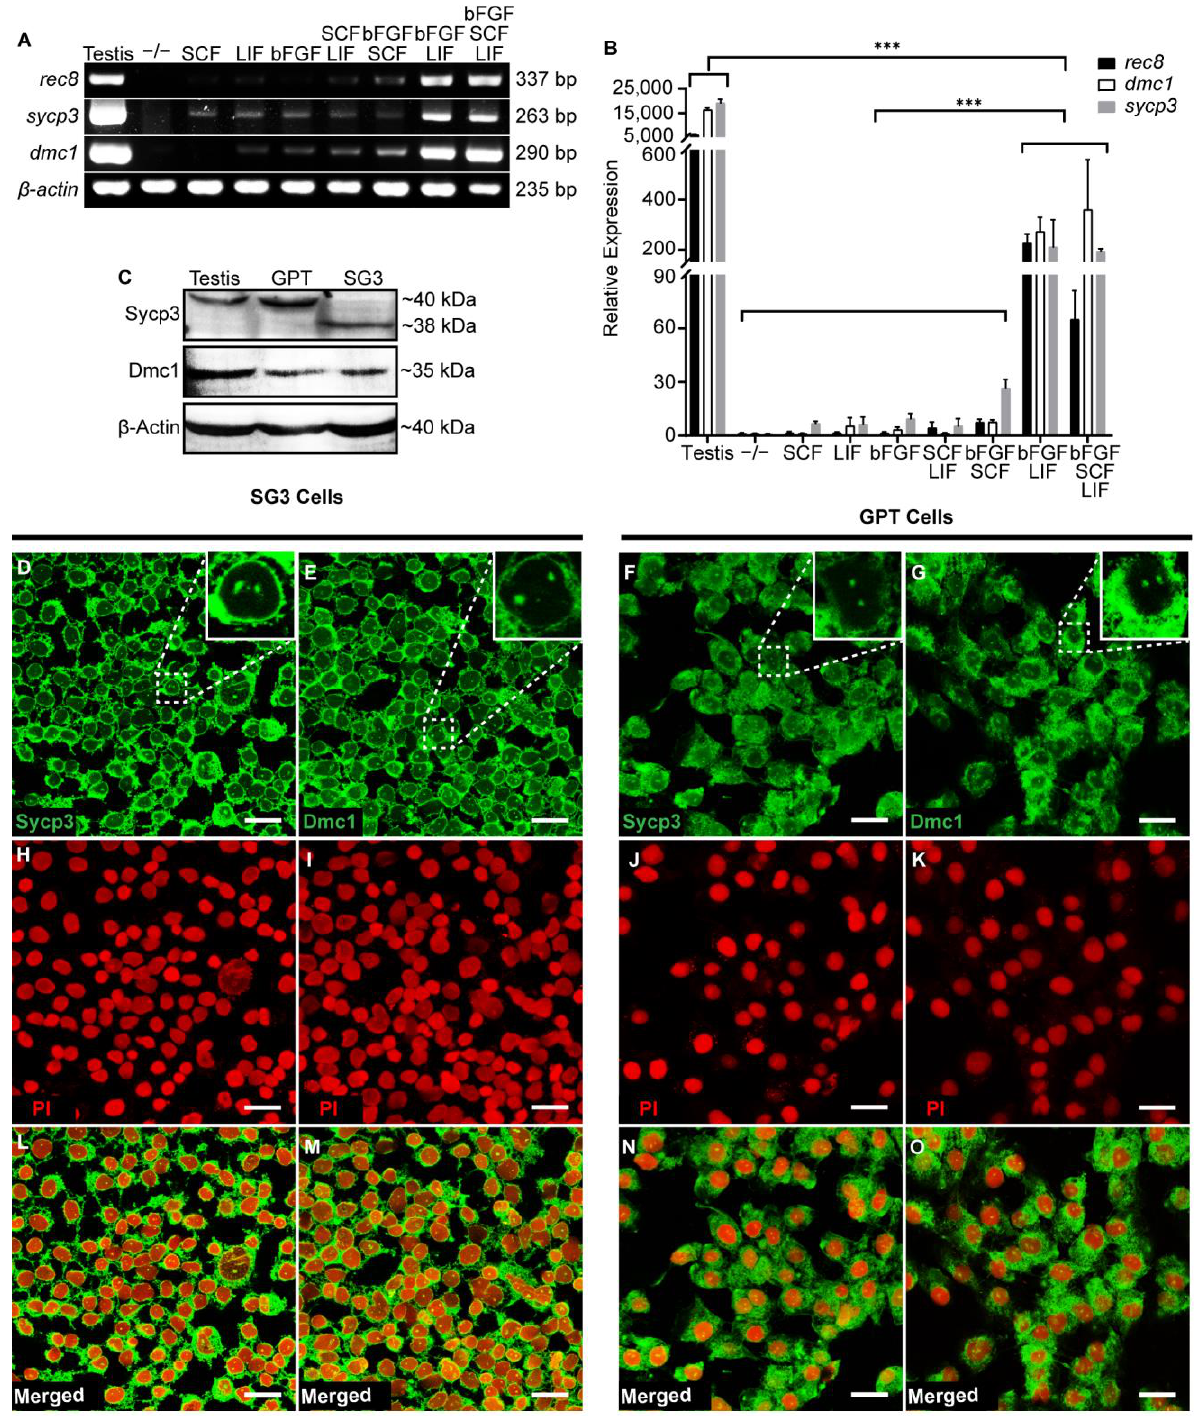
Figure 5. Expression analysis of meiotic markers in GPT cells. ( A ) RT-PCR analysis of the effect of different cytokine combinations on the expression of rec8 , sycp3 , and dmc1 in GPT cells. ( B ) RT-qPCR analysis of the effect of different cytokine combinations on the expression level of rec8 , sycp3 , and dmc1 in GPT cells. The data were shown as the mean ± SEM of three samples and the values with asterisks were significantly different (*** p < 0.001). Statistical analysis was performed by one-way ANOVA and Student’s t -test. The β -actin was used as an internal control. ( C ) Protein expression of Sycp3 and Dmc1 in grouper testis, as well as the GPT cells and SG3 cells treated with bFGF and LIF. The β -Actin was used as an internal control. ( D – G ) Fluorescent immunostaining of Sycp3 and Dmc1 in the SG3 cells and GPT cells treated with bFGF and LIF. ( H – K ) Nucleus was counterstained with PI. ( L – O ) Merge images. Scale Bars: 20 μm.